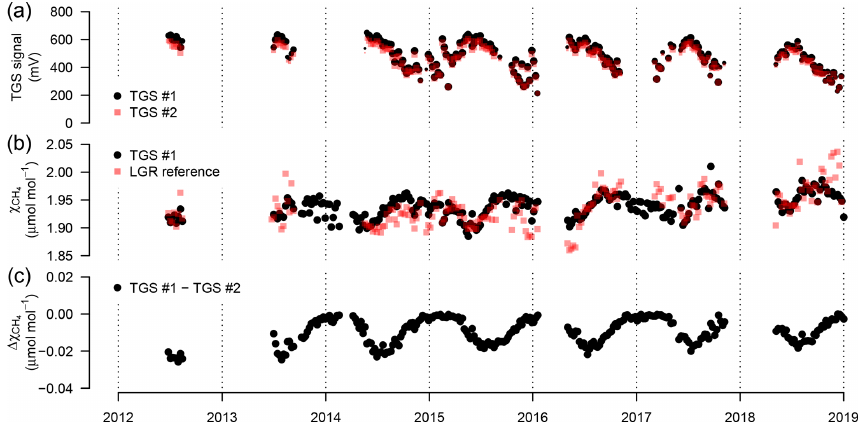
Figure 9. (a) Weekly median sensor signals from both TGS 2600 sensors, (b) CH 4 derived with Eq. (2) for TGS sensor 1 and measured by the Los Gatos Research reference instrument, and (c) absolute difference between the two TGS 2600 sensors. The signals from both sensors were converted to CH 4 using Eq. (2) parameterized with data from TGS sensor 1. Symbol size is proportional to relative data